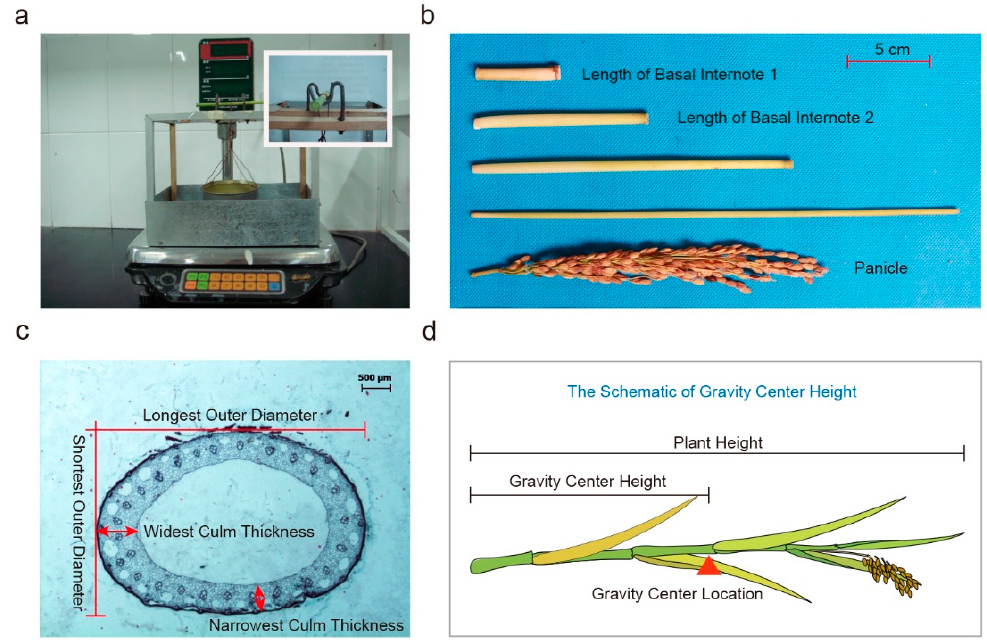
Figure 5. The measurement for lodging resistance related traits in rice: ( a ) the measured instrument for breaking strength of the basal internode; ( b ) the internode of a rice plant; ( c ) the diameter and thickness of a cross-section of the middle point of the basal culm; and ( d ) the schematic of gravity center height.